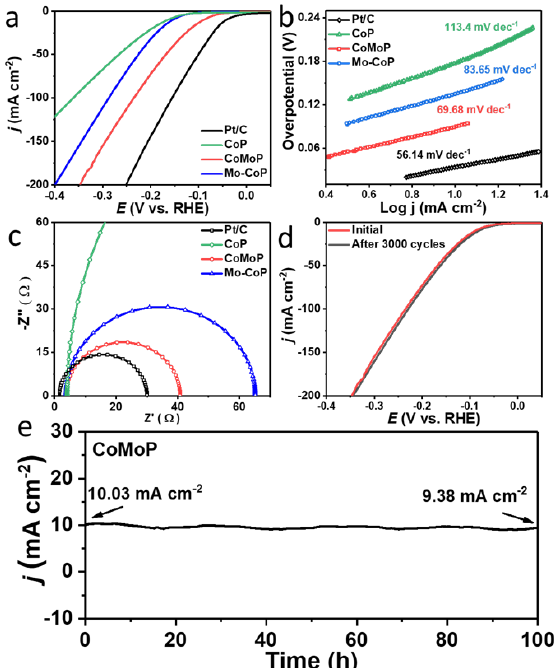
Figure 5. ( a ) HER polarization curves in 1.0 M KOH. ( b ) Corresponding Tafel plots. ( c ) Nyquist plots of the EIS data. ( d ) HER polarization curves before and after 3000 cycles. ( e ) Chronoamperometry data for CoMoP at a 89 mV overpotential.